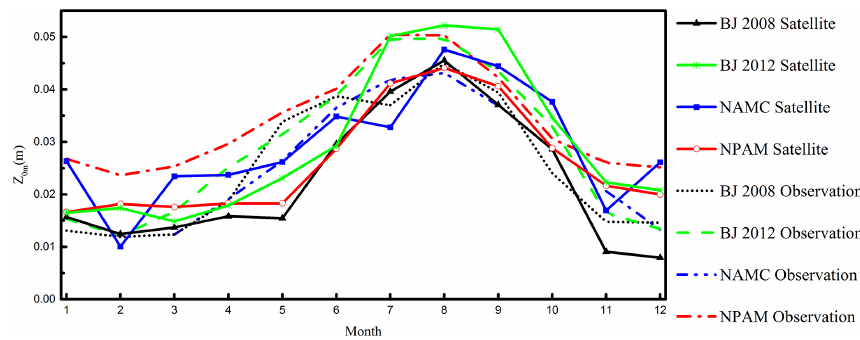
Figure 6. Comparison of the surface roughness length by site observations and satellite-remote-sensing-retrieved